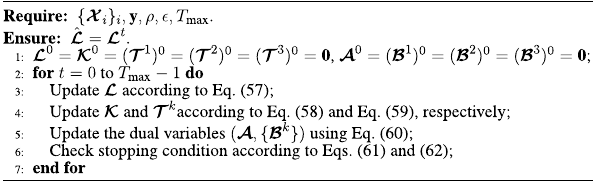
Algorithm 1. ADMM for Problem (55